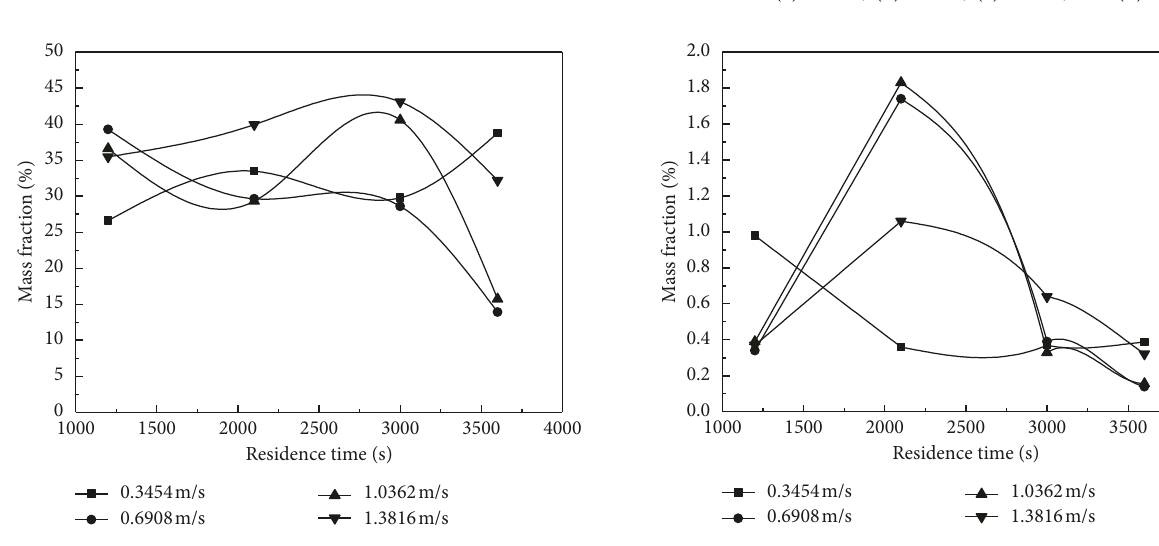
Figure 8: The influence of circulation flow rates on mass fraction of crystal of size less than 0.245mm for different residence times.